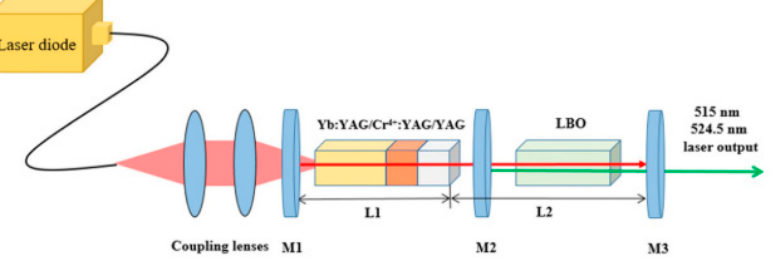
Figure 8. Experimental setup of passive Q-switched frequency-doubled laser based on Yb:YAG/Cr 4+ :YAG/YAG composite crystal.